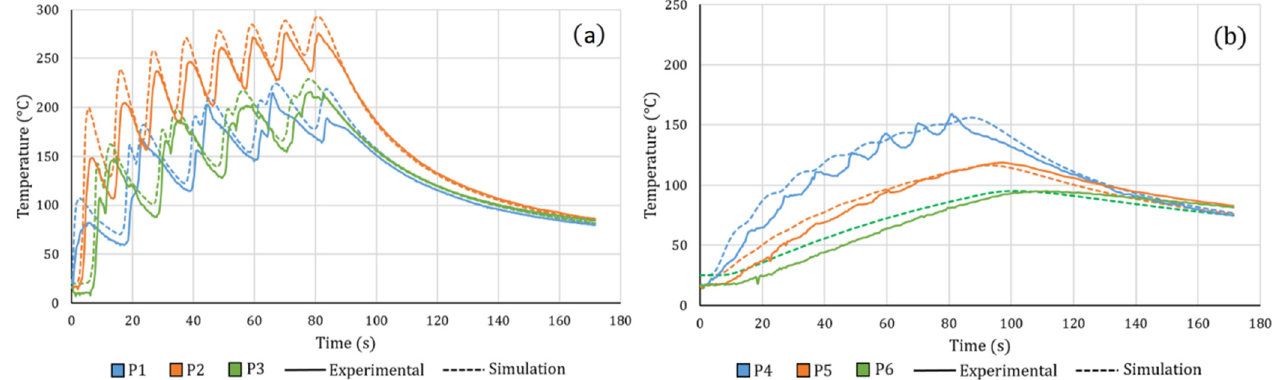
Fig. 7. Measured and calculated temperatures at control points: (a) P1, P2 and P3 (b) P4, P5 and P6.